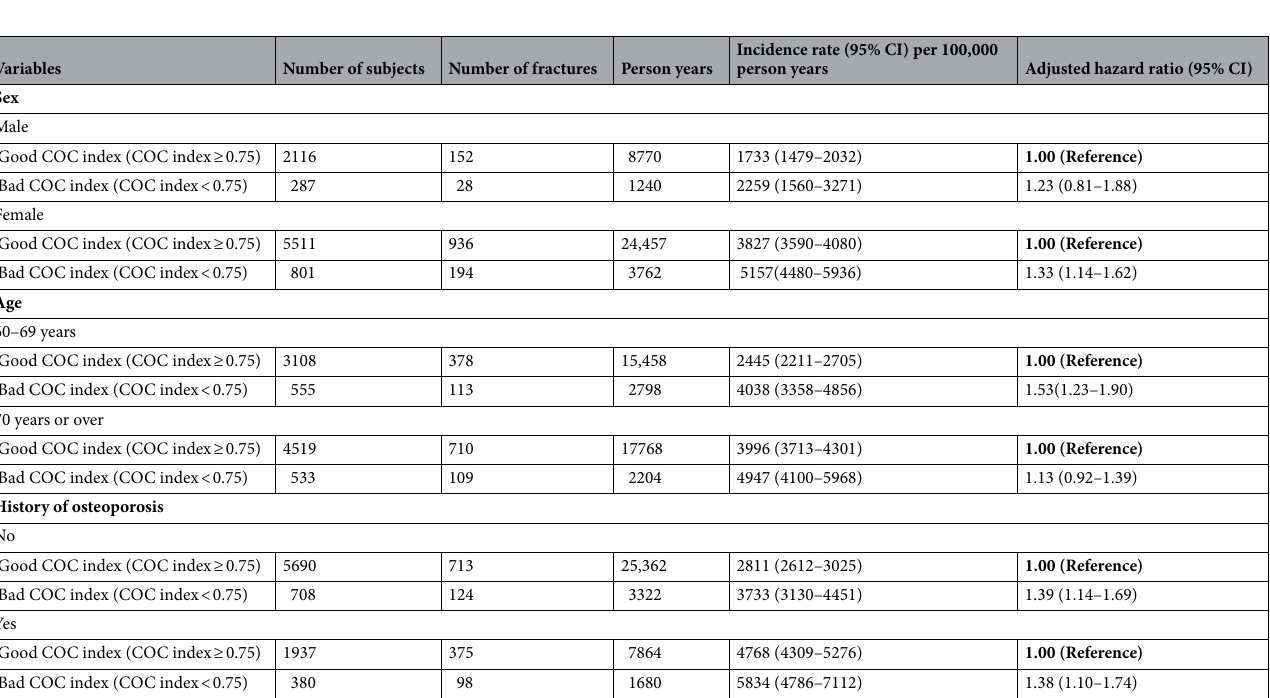
Table 5. Continuity of care and major osteoporotic fracture risk stratified by sex, age, and osteoporosis history. Adjusted with all covariates. COC continuity of care, CI confidence